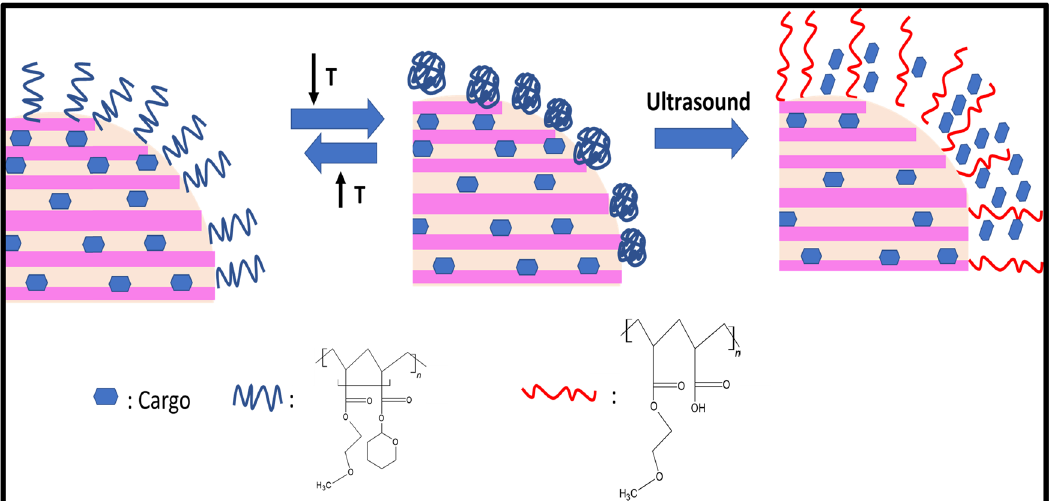
Figure 7: Schematic illustration of Ultrasound responsive systems.